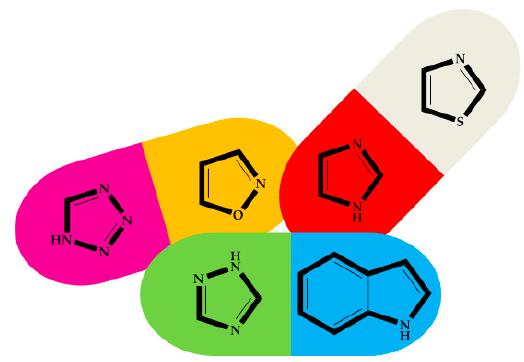
Figure 1. Five-membered aromatic nitrogen Figure 1. Five ‐ membered aromatic nitrogen heterocycles .